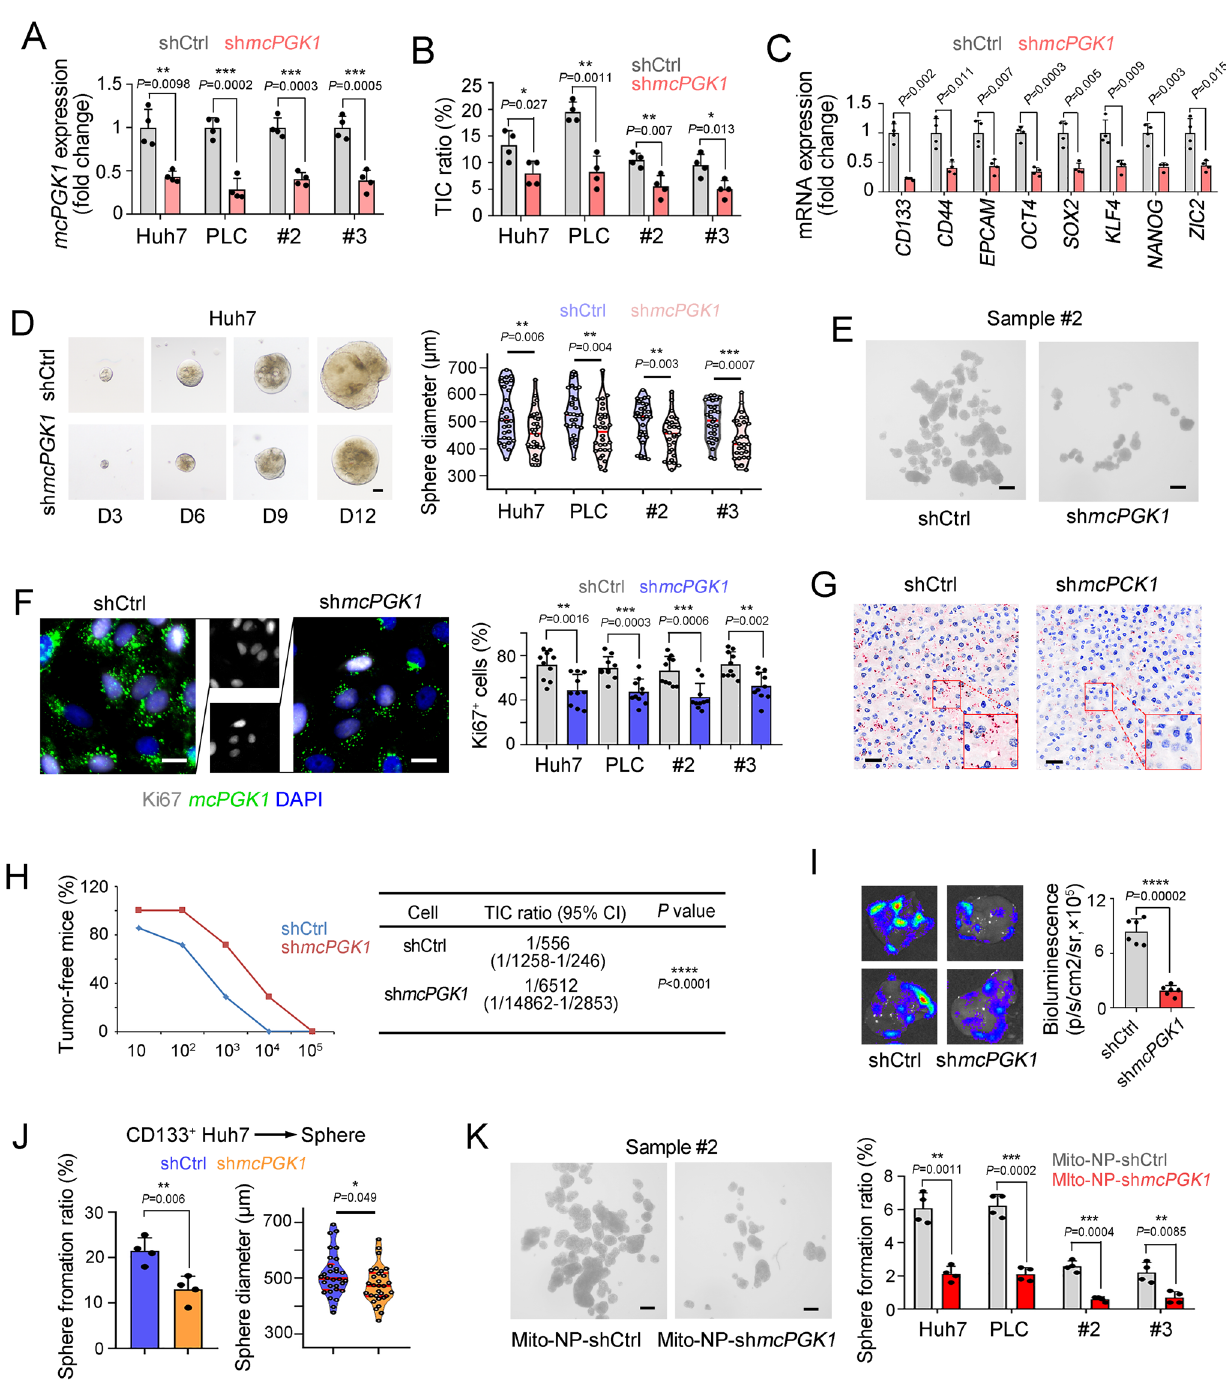
Fig. 2 | McPGK1 is required for liver TIC self-renewal. A Quantitative real-time PCR to con fi rm the knockdown ef fi ciency in mcPGK1 silenced cells. B FACS detection of mcPGK1 silenced cells for CD133 expression. C Quantitative real-time PCRanalysisofTICmarkersandTIC-associatedTFsin mcPGK1 silencedandcontrol cells. D Sphere formation of mcPGK1 silenced and control cells. Typical sphere images were in the left panel and sphere diameters of n =30 spheres from three independent experiments were measured in the right panel. D3, day 3. Scale bars, 100 μ m. E Sphere formation of mcPGK1 silenced and control HCC #2 sample cells. Scale bars, 500 μ m. F McPGK1 fl uorescence in situ hybridization and Ki67 staining in mcPGK1 silenced and control Huh7 cells. Typical images and Ki67 + ratios were shown.For each group, n =10 fi eldswereobserved. Scalebars,10 μ m. G , H Tumor initiation assay of gradient numbers of mcPGK1 silenced and control cells derived from spheres derived from primary #2 cells. mcPGK1 detection for knockdown